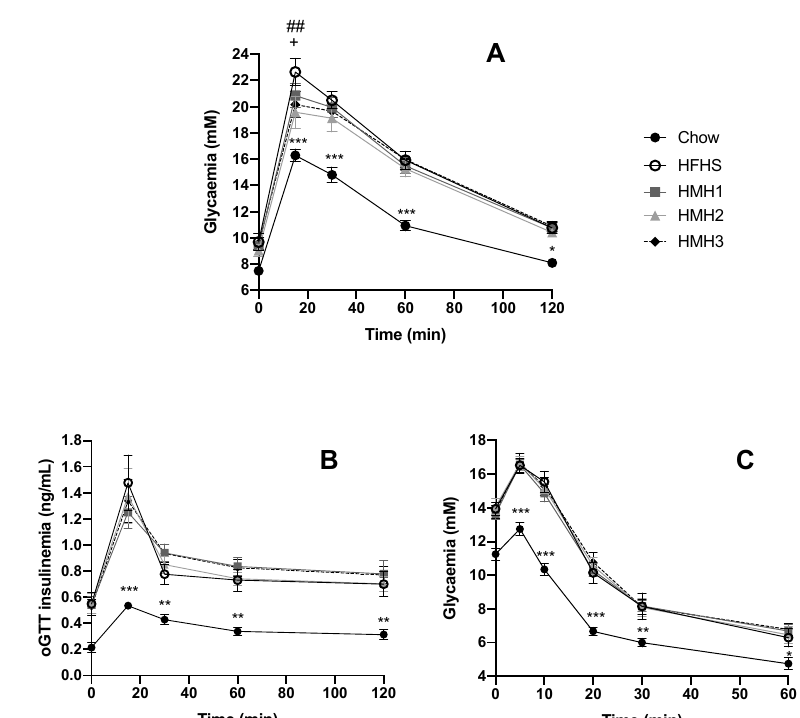
Figure 1. Herring milt hydrolysate (HMH2 and HMH3) improved early time point glycemia during the oral glucose tolerance test (OGTT) ( n = 11 − 12). ( A ) Glycemic curve during the OGTT for HMH1, HMH2, and HMH3 treatment at a dose of 208.8 mg / kg; ( B ) insulin production during the OGTT for HMH1, HMH2, and HMH3 treatment; ( C ) glycemic curve during the insulin tolerance test (ITT) for HMH1, HMH2, and HMH3. Time points within the di ff erent groups were compared using a two-way repeated measure analysis of variance (ANOVA) with a post-hoc Student–Newman–Keuls test. * p < 0.05 chow vs. HFHS, ** p < 0.01 chow vs. HFHS, *** p < 0.001 chow vs. HFHS, ## p < 0.01 HFHS